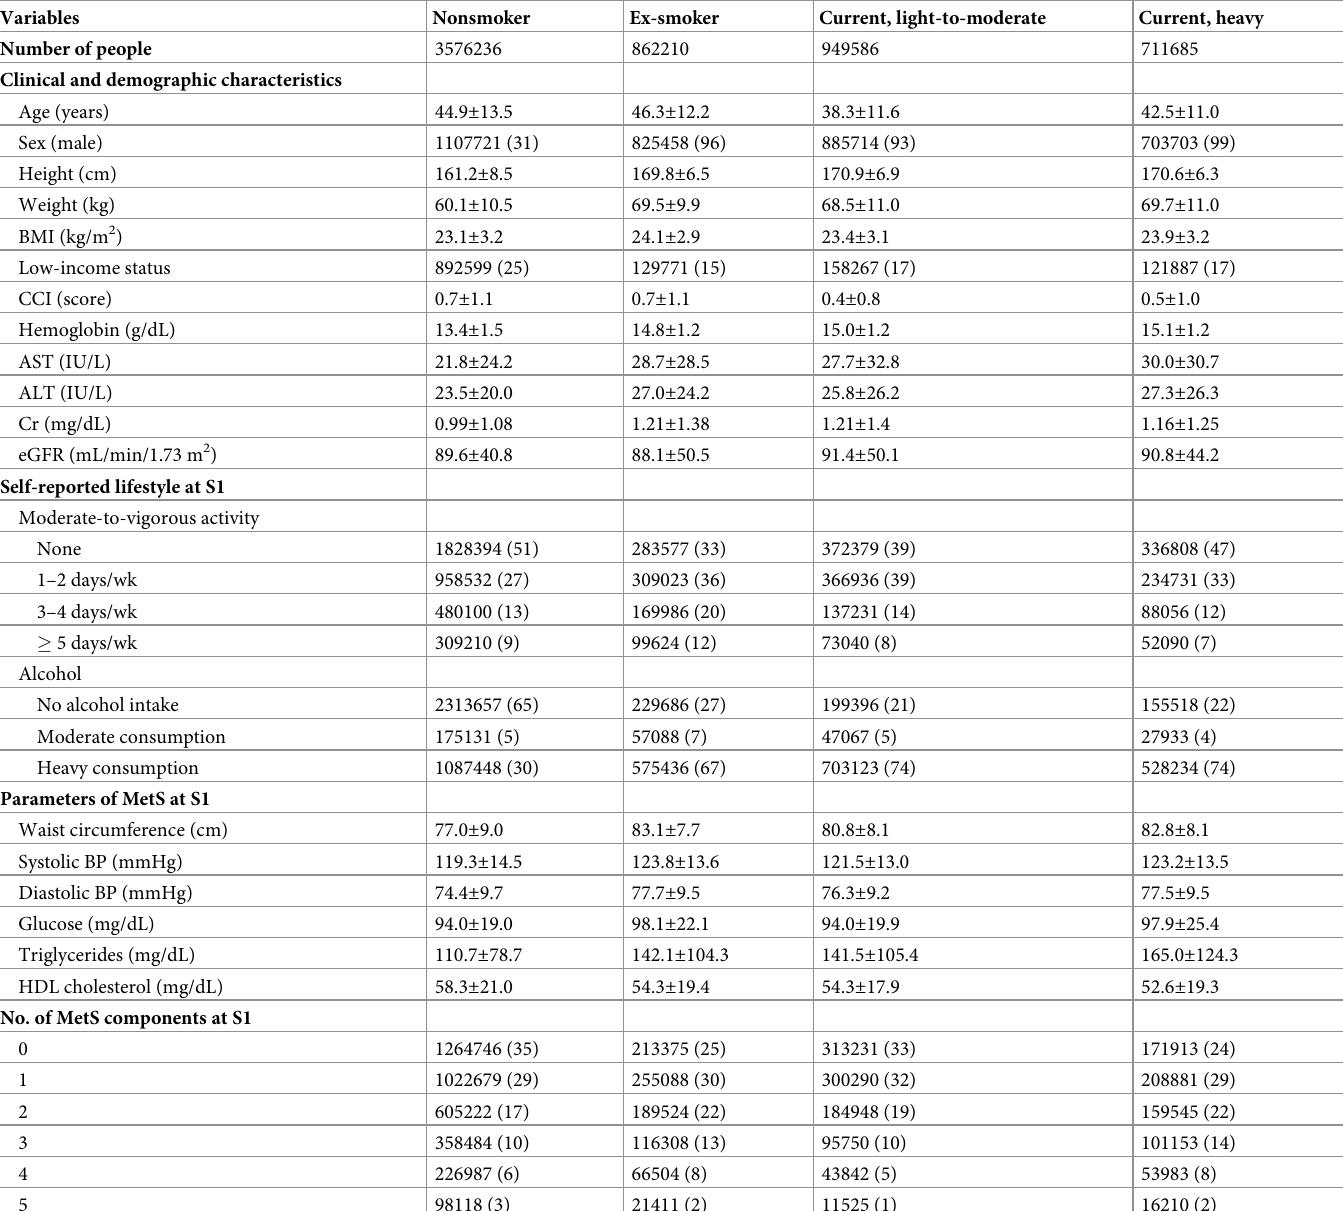
Table 1. Characteristics of the study population at the first health screening